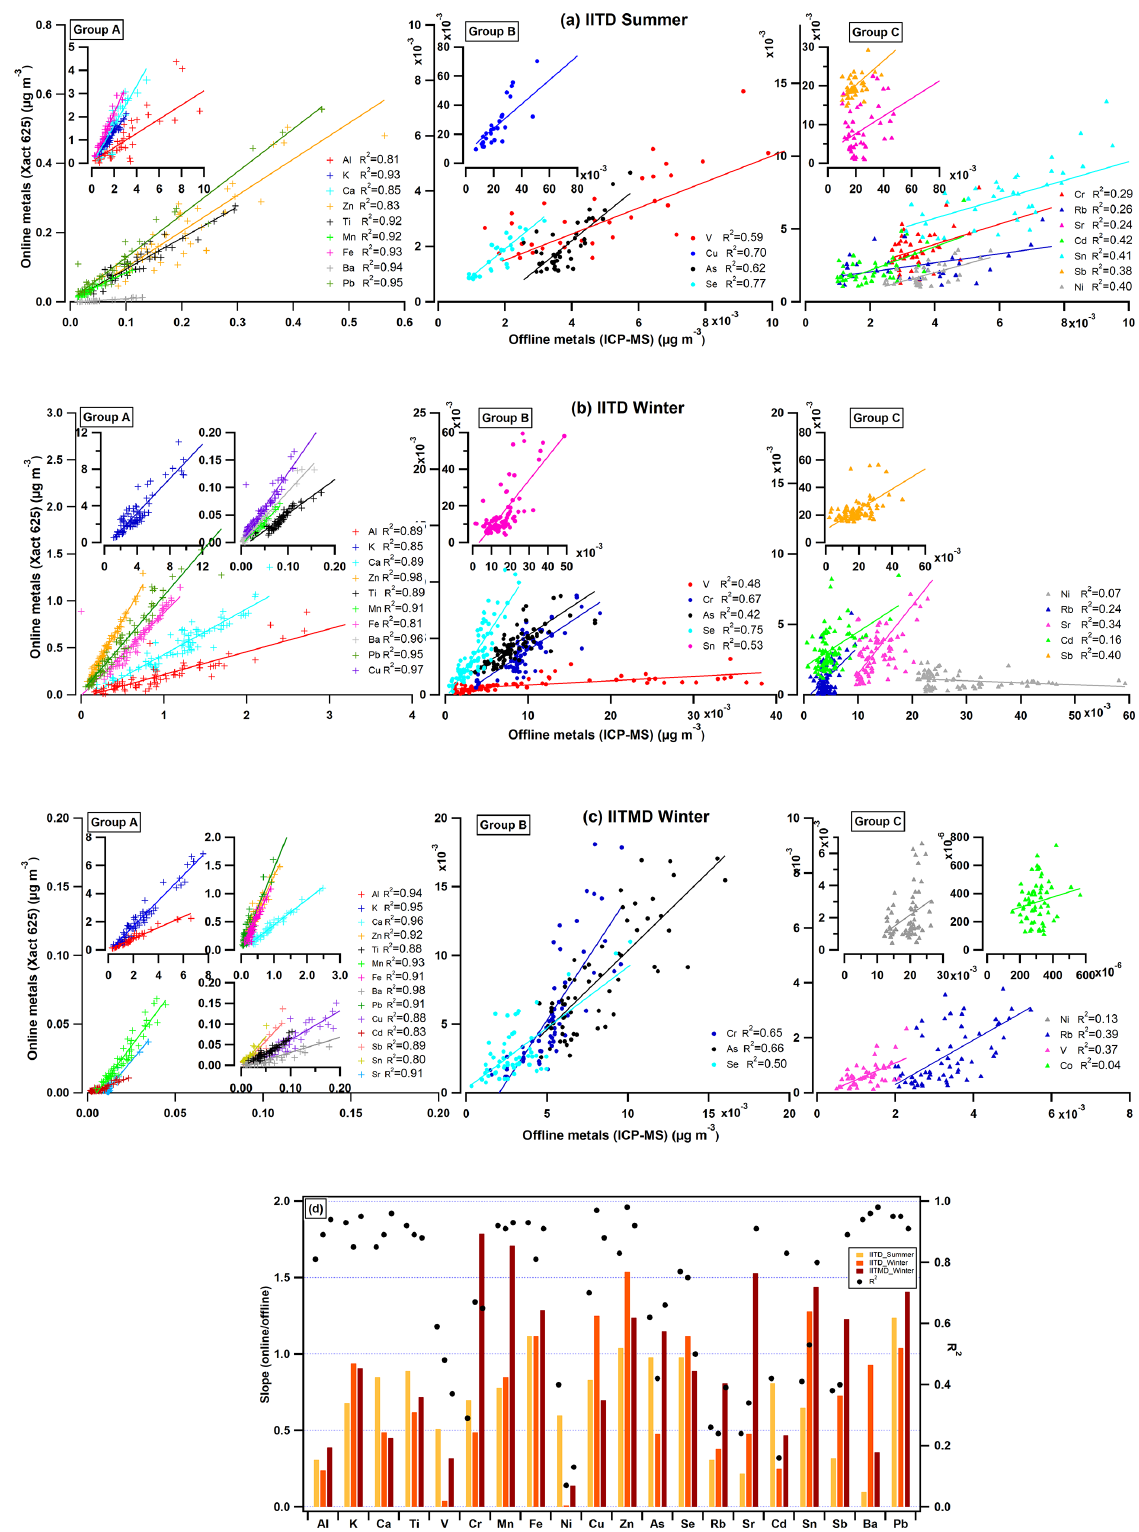
Figure 6. Scatterplots and regression lines of Xact 625i vs. ICP-MS data for groups A, B, and C during (a) summer at IITD, (b) winter at IITD, and (c) winter at IITMD and (d) comparison of slopes (online / offline) and R 2 of the measured heavy and trace metals in PM 2 . 5 during the summer and winter campaigns at IITD and winter campaign at